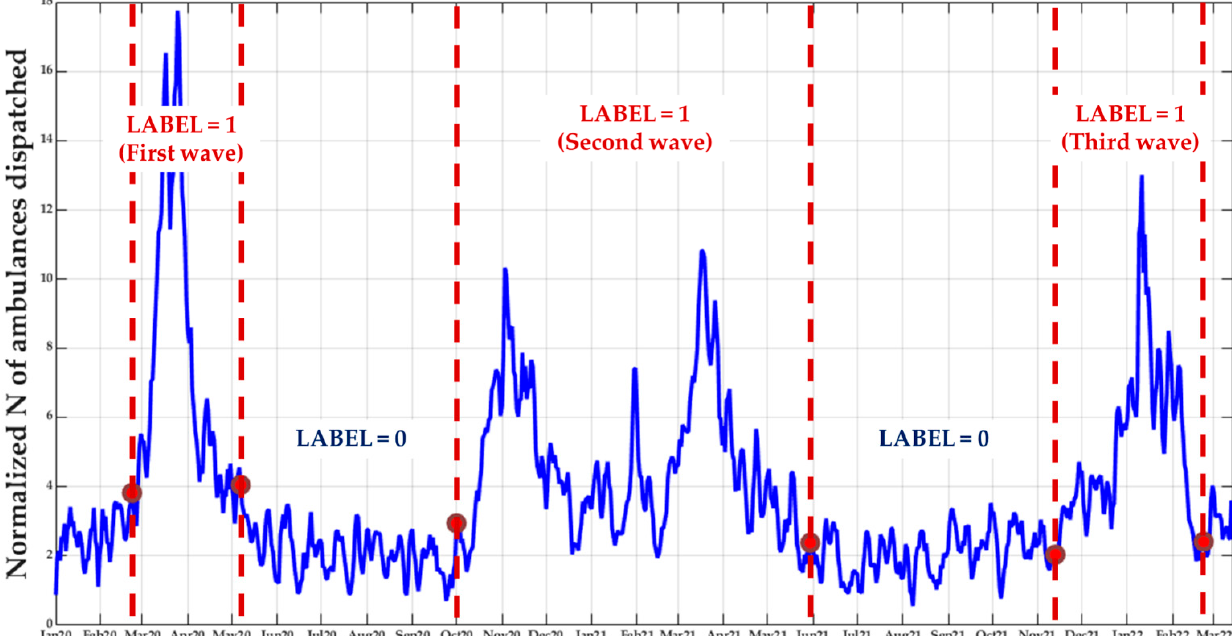
Figure 1. Subdivision of the time series, representing the vehicles dispatched by EMS for respiratory and infective issues (normalized by the resident population) in a certain territory, in periods where a label (0 = ’no diffusion’; 1 = ‘active spreading’) was assigned to each point generated, according to the automated identification of inflection points (change in the shape of the data, see [34] for more details).